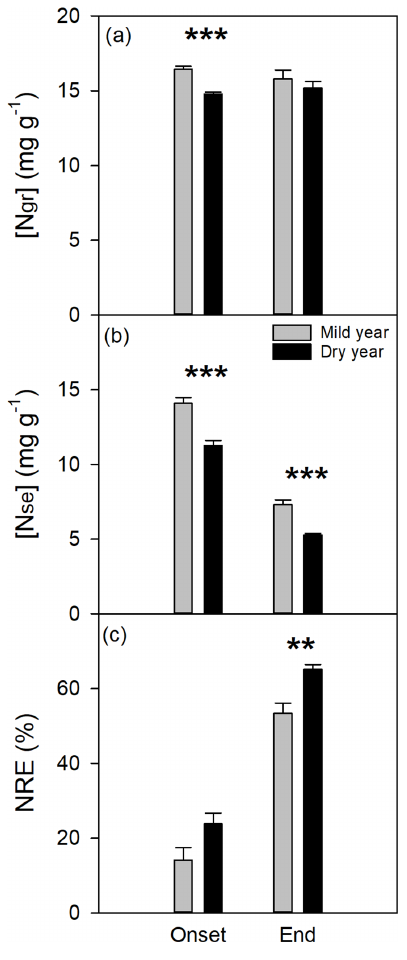
Figure 6. Nitrogen dynamics evaluated at the onset and end of bulk leaf senescence period in the mild and dry years. (a) Nitrogen con- centration in green leaves ([N gr ], mgg − 1 ). (b) Nitrogen concentra- tion in senescent leaves ([N se ], mgg − 1 ). (c) Nitrogen resorption ef- ficiency (NRE, %). Values are mean ± SEM ( n = 6). Significant dif- ferences between years are indicated when ∗ p< 0 . 05, ∗∗ p< 0 . 01, and ∗∗∗ p< 0 .